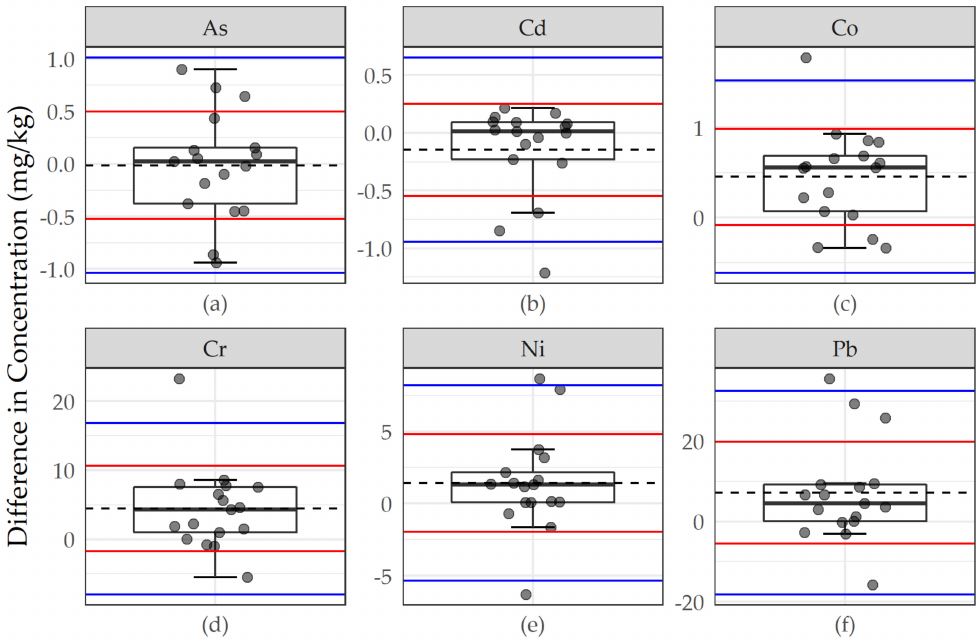
Figure 3. Di ff erences in concentration between youth scientists and expert replicates for ( a ) As, ( b ) Cd, ( c ) Co, ( d ), Cr, ( e ) Ni, and ( f ) Pb. Points represent paired di ff erences, summarized by underlying boxplots. Dashed lines represent the mean paired di ff erence between youth primary and expert replicate samples; red and blue lines represent “bounds of agreement” at ± 1 and ± 2 standard deviations, respectively, about the mean di ff